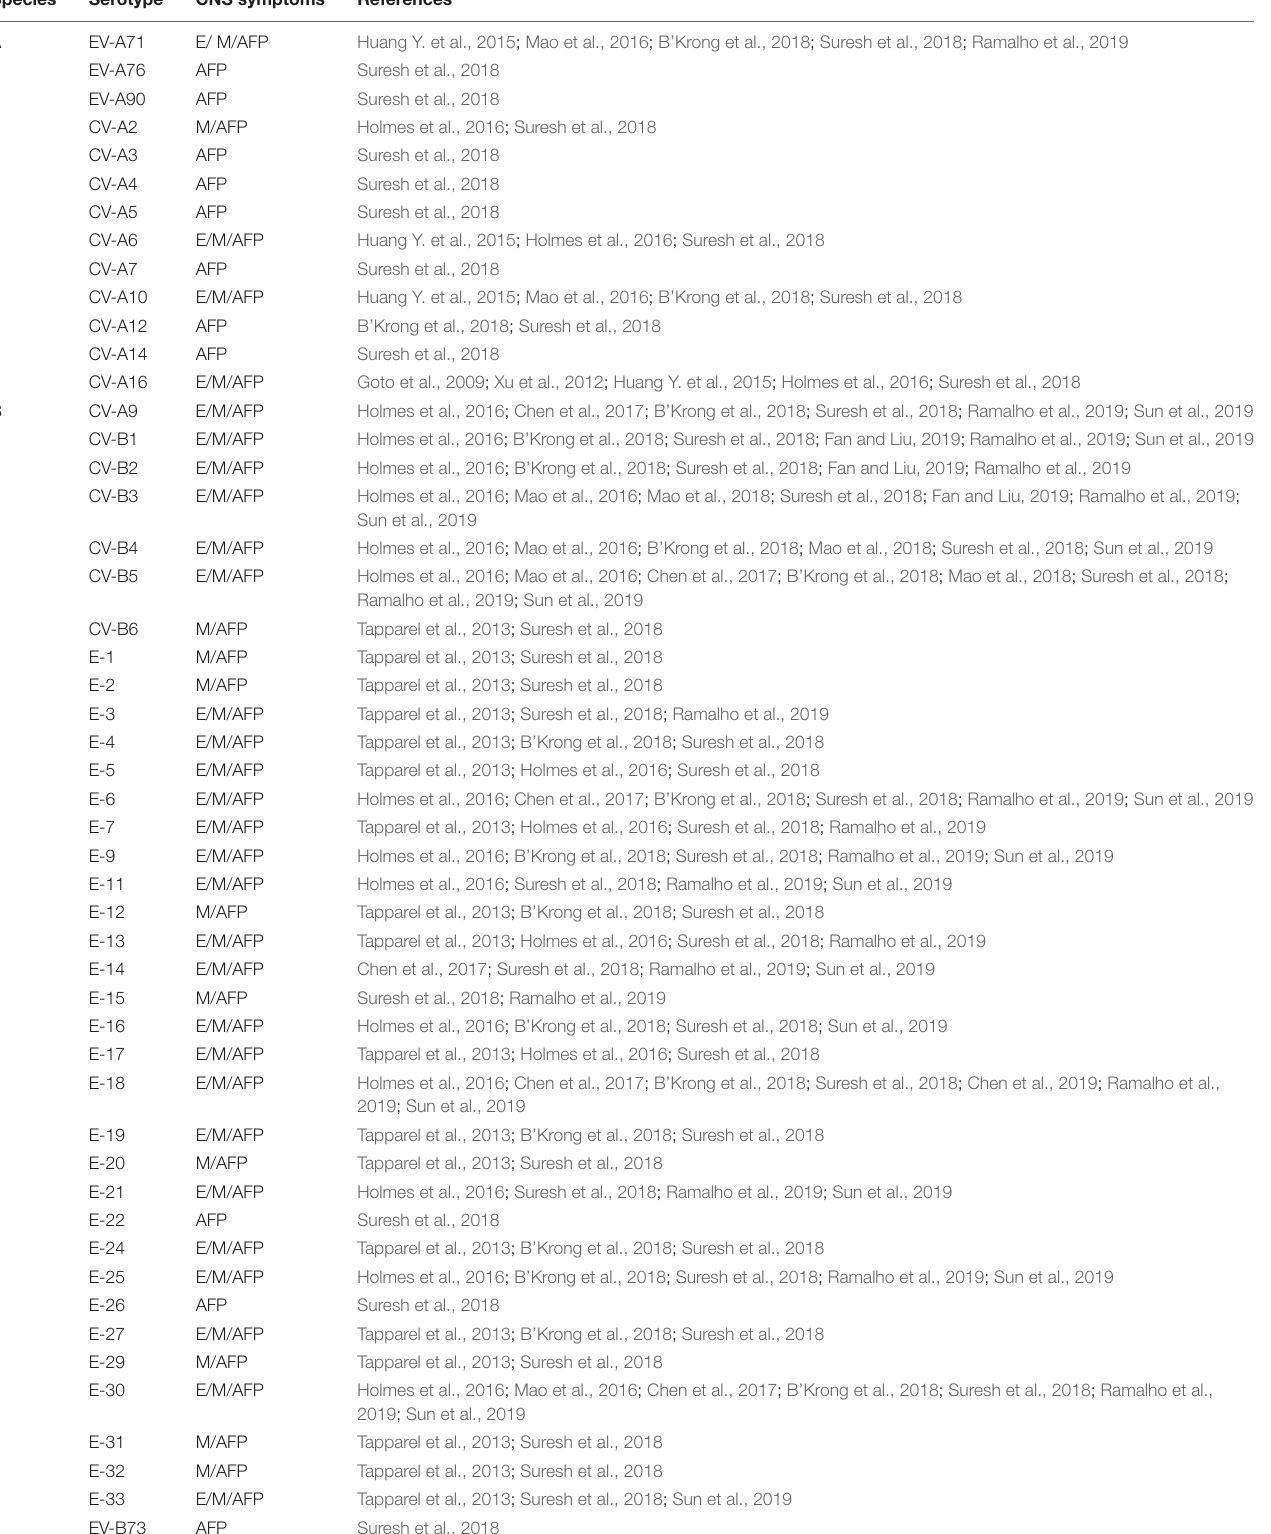
TABLE 1 | Neurological symptoms of non-polio enteroviruses that involve the CNS. Species Serotype CNS